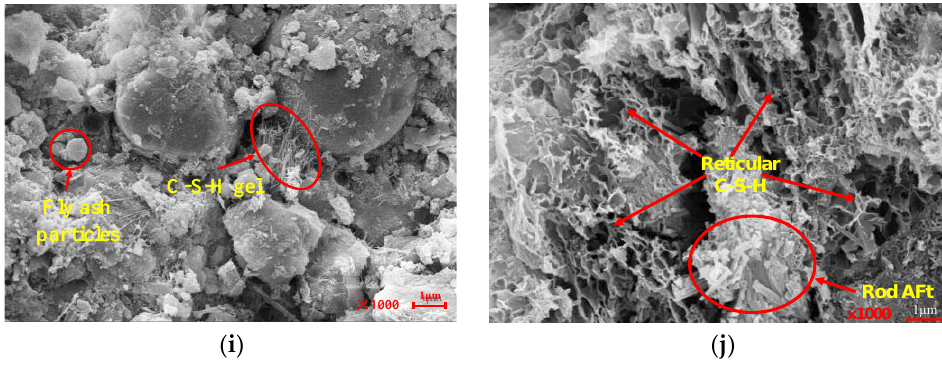
Figure 15. Microstructure of the mixture: ( a – c ) curing time of 7 days, ( d – f ) curing time of 28 days, and ( g – j ) curing time of 90 days.